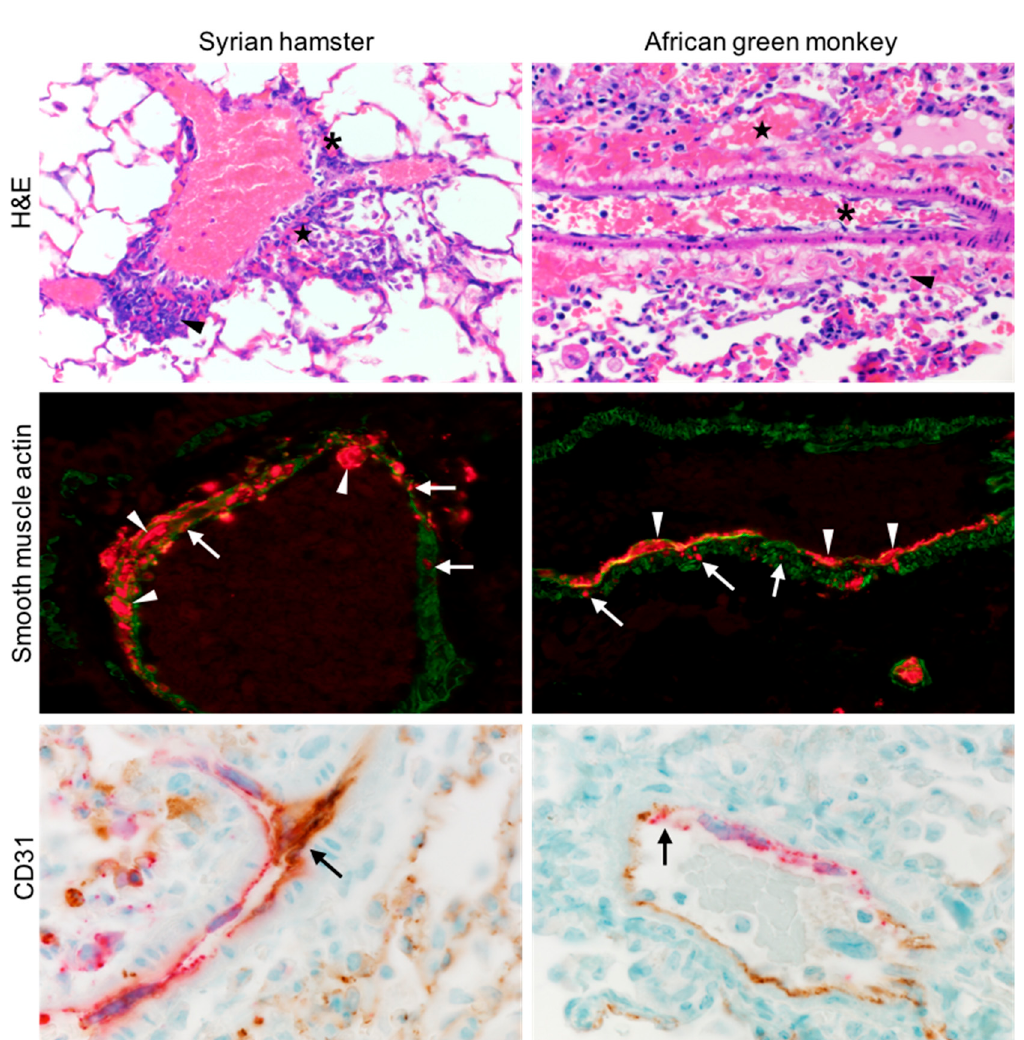
Figure 1. Lung tissue from hamsters ( left column ) and AGMs ( right column ) infected with NiV were sectioned and stained by H&E ( top row ). Asterisks denote degeneration of the endothelium, stars denote hemorrhage, and arrowheads highlight perivascular inflammation. NiV NP ( red ) and smooth muscle actin ( green ) are shown ( middle row ), arrows point to infected SMC, and arrowheads infected ECs, displaying syncytia. NiV NP ( red ) and CD31 ( brown ) are shown ( bottom row ), showing extensive colocalization and infection of ECs and the formation of multinucleated giant cells ( arrows